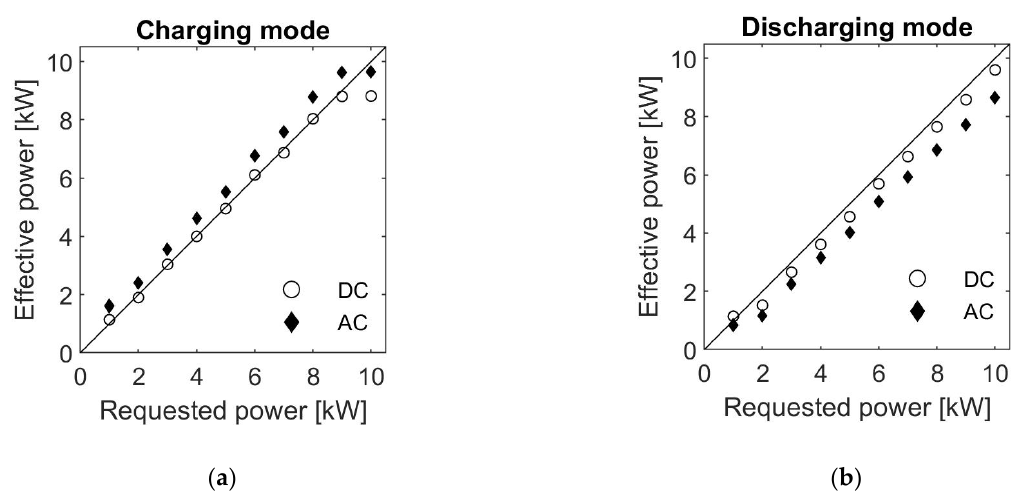
Figure 7. DC (filled diamonds) and AC (circles) power measurements for the requested set points ( a ) in charging mode; ( b ) and in discharging mode. The V2G system is shown to implement the requested power as DC. Each value represents the average of four identical tests, with a standard deviation ranging ±0.01 kW and ±0.2 kW.